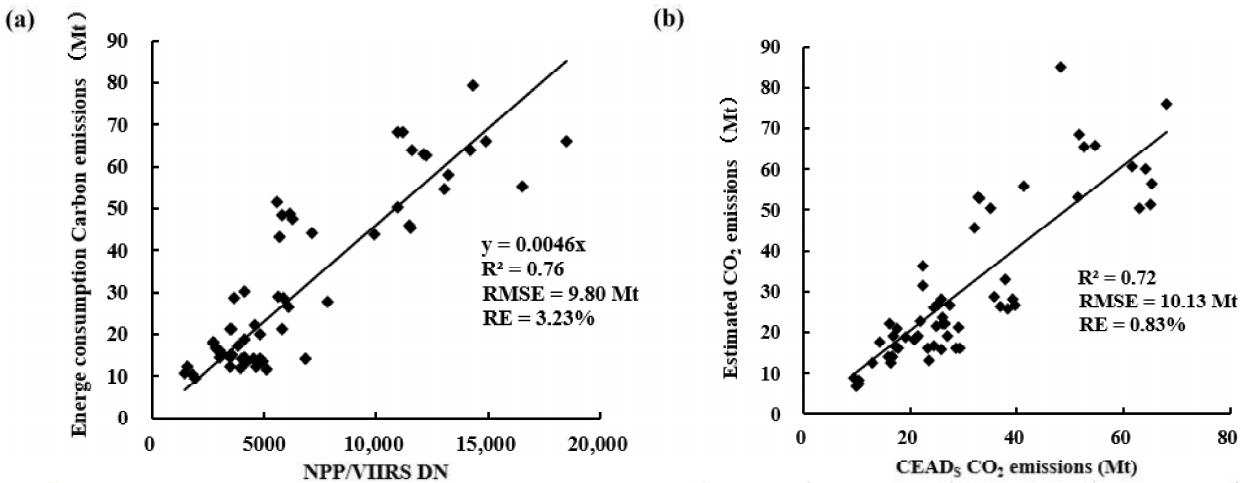
Figure 3. ( a ) Fitting model of energy consumption carbon emissions and ( b ) accuracy verification.